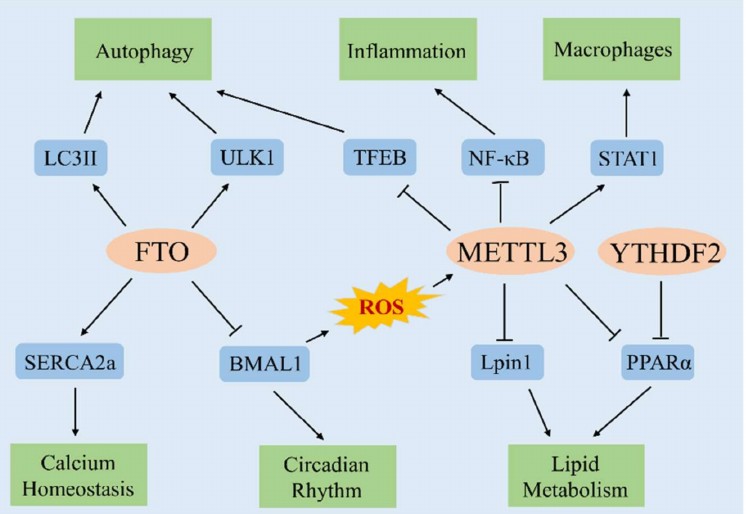
Figure 2. Potential mechanisms of m6A methylation in the regulation of CMDs. FTO regulates calcium-ion homeostasis by increasing the protein expression of SERCA2a, and regulates the circadian rhythm by inhibiting the expression of BMAL1. Deletion of BMAL1 leads to the accumulation of ROS, which in turn regulates the expression of Lpin1 and PPAR α by increasing the expression of METTL3. YTHDF2 and METTL3 jointly affect the transcription and translation of PPAR α and regulate lipid metabolism. Moreover, silencing of METTL3 upregulates TFEB expression, thereby enhancing autophagy. FTO also promotes autophagy by upregulating the expression of ULK1 and LC3II. METTL3 reduces inflammation by inhibiting the NF- κ B pathway and upregulates the expression of STAT1 to promote M1 macrophage polarization. “ → ” refers to promotion, “— | ” refers to